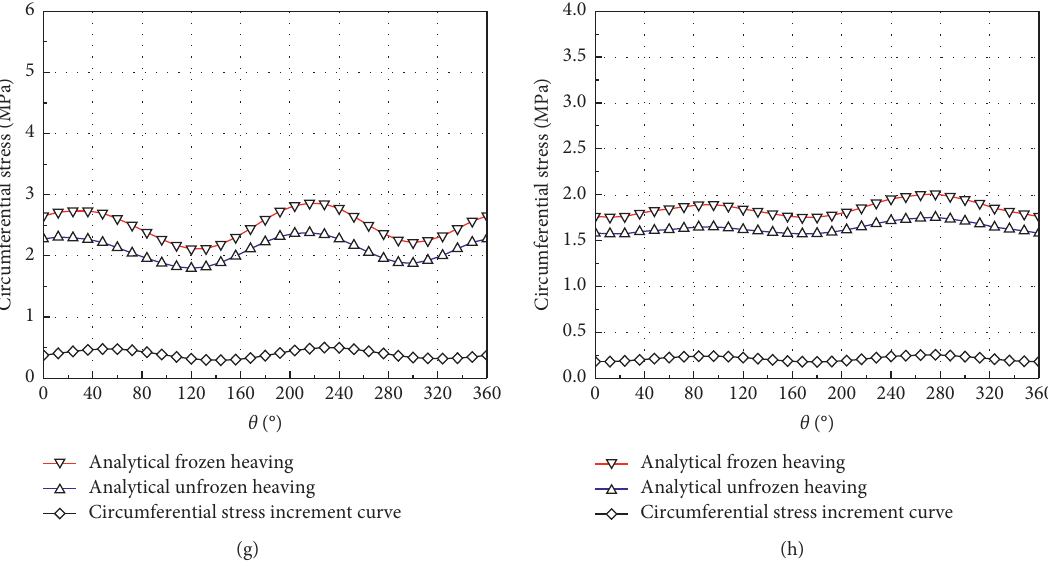
Figure 5: Circumferential stresses on the outer boundary of the lining for different bedding angles of the surrounding rock. (a) Ho- mogeneous isotropic rock mass. (b) Bedding angles of 0 ° . (c) Bedding angles of 15 ° . (d) Bedding angles of 30 ° . (e) Bedding angles of 45 ° . (f) Bedding angles of 60 ° . (g) Bedding angles of 75 ° . (h) Bedding angles of 90 °